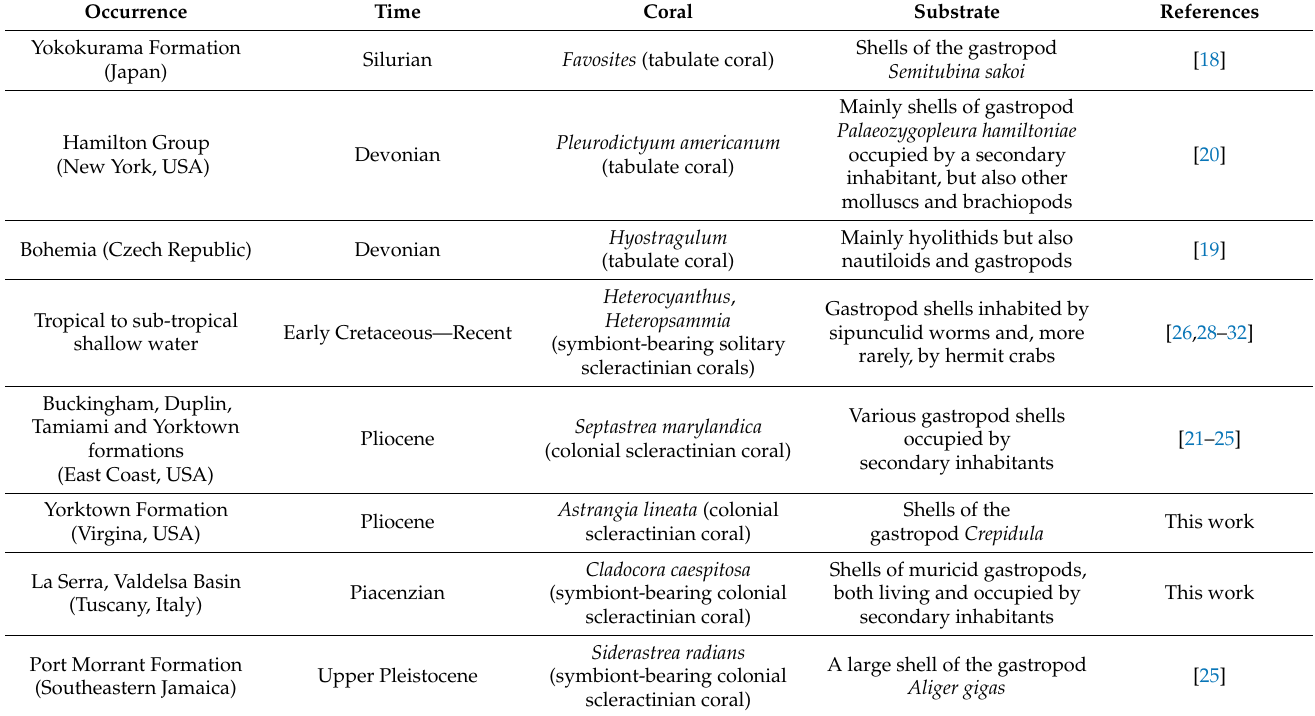
Table 1. General overview of relevant occurrences of gastropod shells encrusted by stony corals through geological